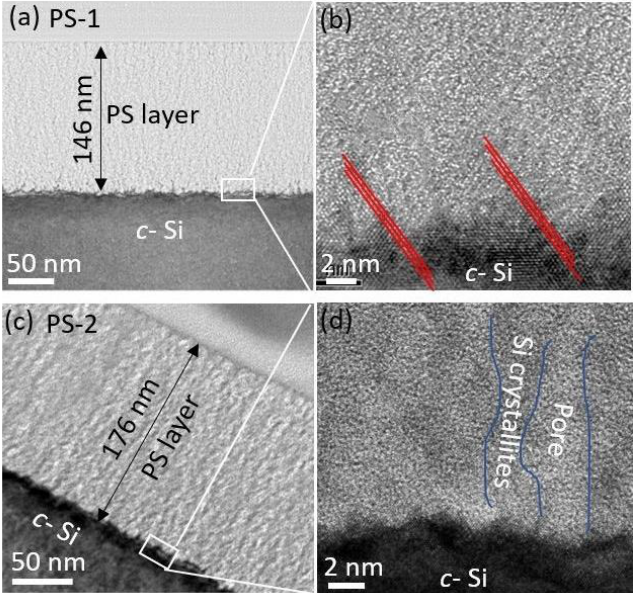
Figure 3. ( a ) TEM image of 146-nm-thick PS-1 layer; ( b ) HRTEM of PS-1/ c -Si interface at the bottom of PS-1 layer; ( c ) TEM image of 176-nm-thick PS-2 layer; ( d ) HRTEM of PS-2/ c -Si interface at the bottom of PS-2 layer.